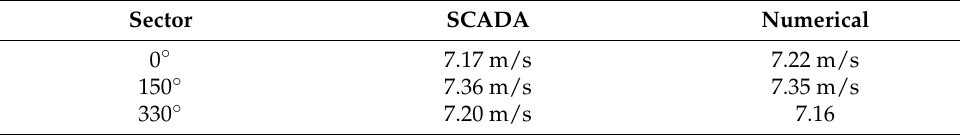
Table 3. Average measured and simulated wind speed: low wind regime.